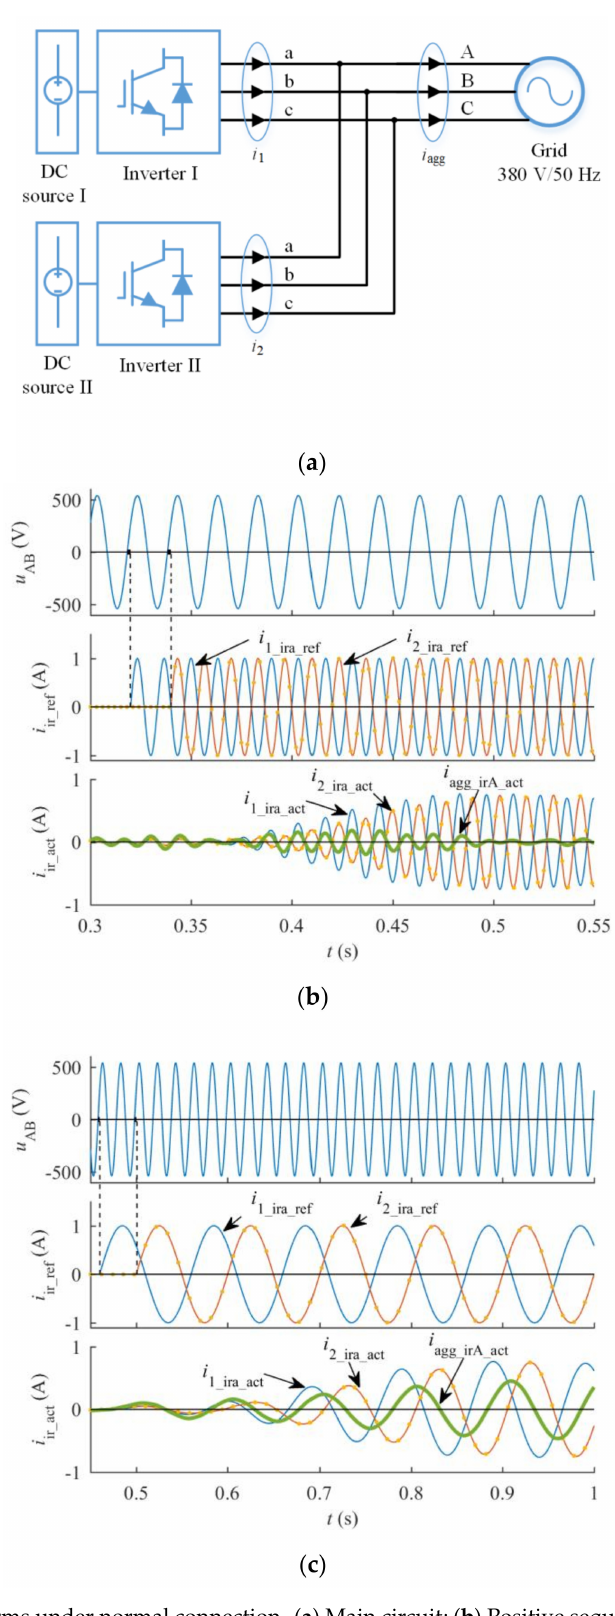
Figure 11. Waveforms under normal connection. ( a ) Main circuit; ( b ) Positive sequence high-frequency current (75 Hz); ( c ) Positive sequence low-frequency current (10 Hz). u AB : reference terminal voltage (50 Hz). The meaning of the subscripts: ref, reference current; act, actual current; ira, irregular current of phase a; agg, aggregate